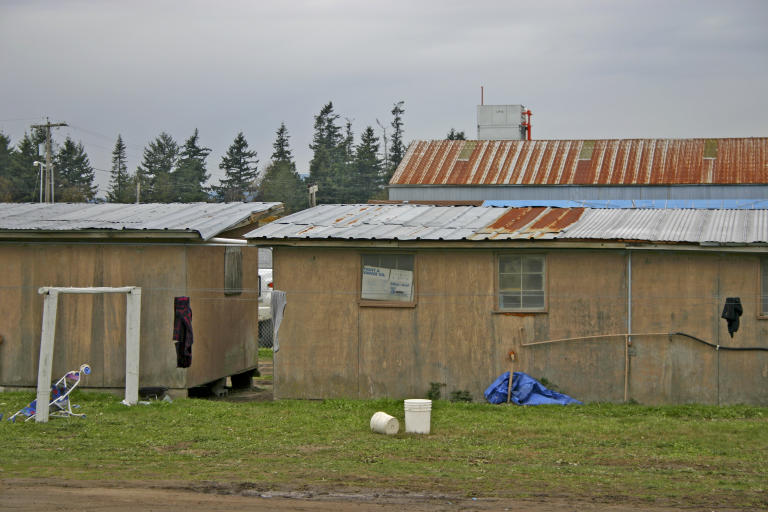
Labor Camp on the Tanaka FarmEach of the Tanaka Farm's labor camp units, called “cabins” by farm executives, is split in half, with each side housing one family.